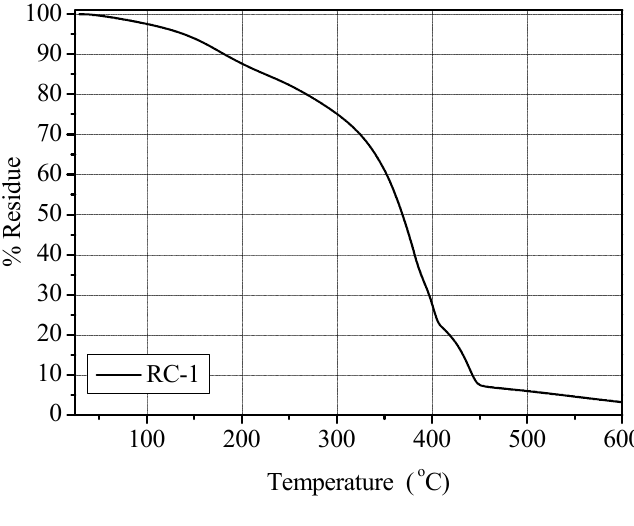
Figure 2. TGA analysis under N polymer electrolyte